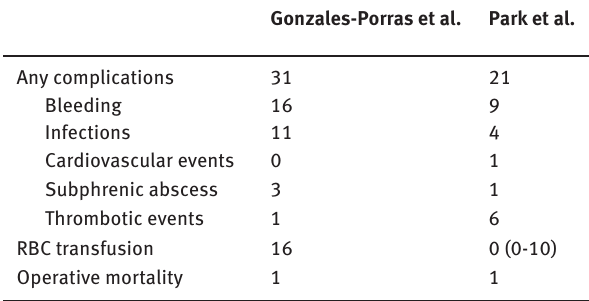
Table 5: Postoperative complications Gonzales-Porras et al. Park et